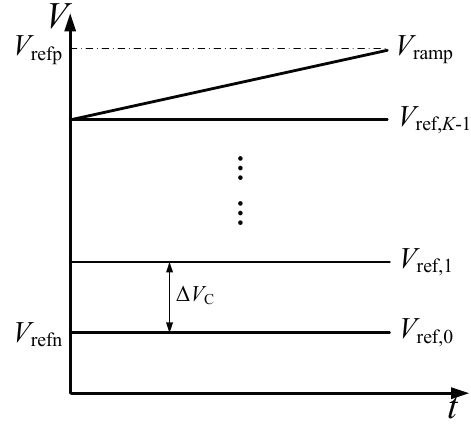
Figure 2. The ramp voltage and K reference